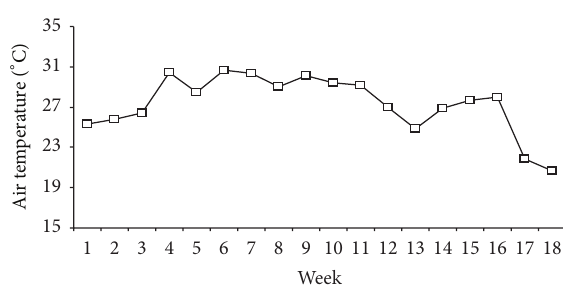
Figure 1: Changes in mean weekly air temperature during the rice- growing